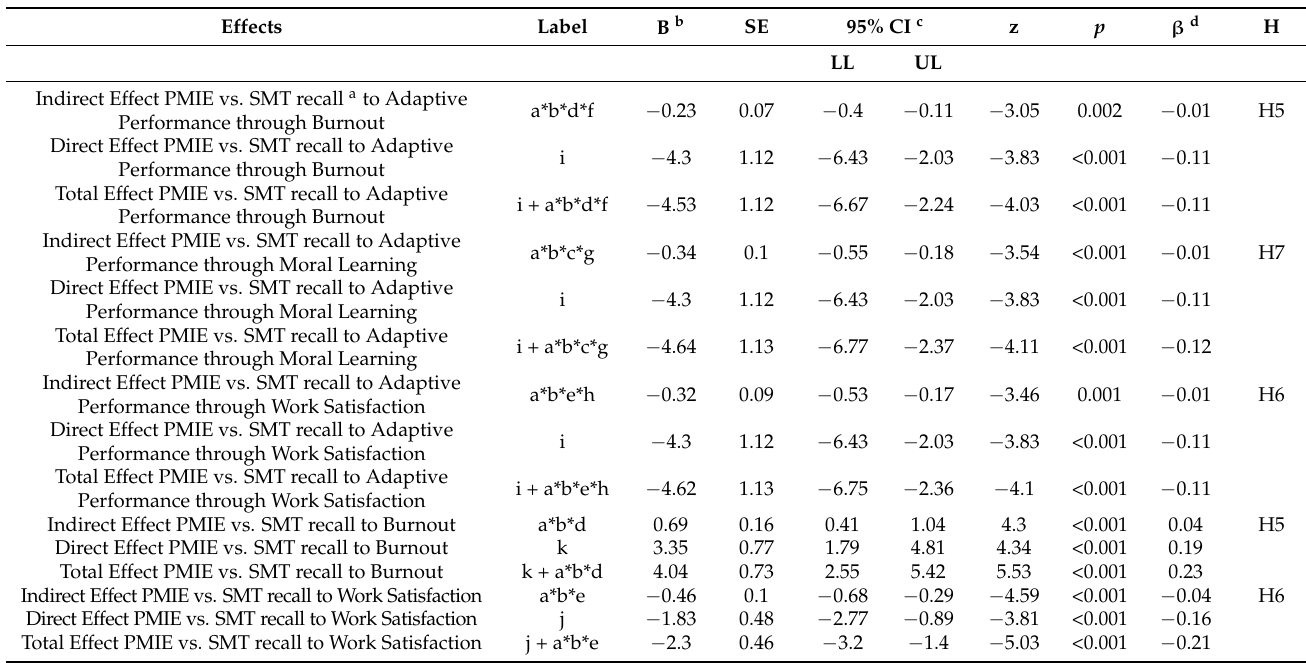
Table 6. Path Analysis Indirect